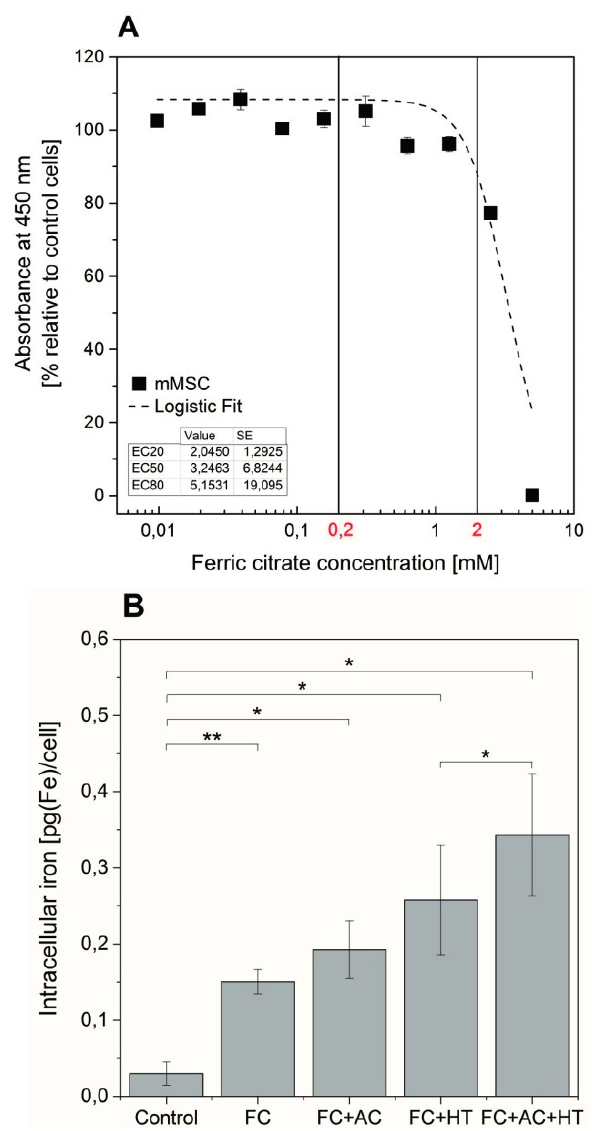
Figure 2. Iron uptake and cytotoxicity. ( A ) Cell viability of MSCs when exposed to different doses of ferric citrate; ( B ) Effect of culture medium supplements on intracellular iron content. FC: 0.2 mM ferric citrate; AC: 50 µM L -ascorbic acid; HT: 1.28 mM human holo-transferrin. Error bars represent SEM ( n = 3). * denotes p < 0.05 and ** p <